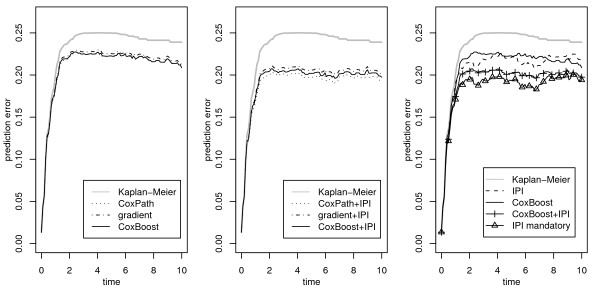
.632+ prediction error estimates. .632+ prediction error curve estimates for microarray-only models (left panel) fitted by CoxPath, gradient boosting, and componentwise CoxBoost, for models including the IPI as an additional optional covariate (middle panel), and for the CoxBoost fit that incorporates the IPI as a mandatory covariate (right panel). The Kaplan-Meier benchmark is indicated by gray curves.